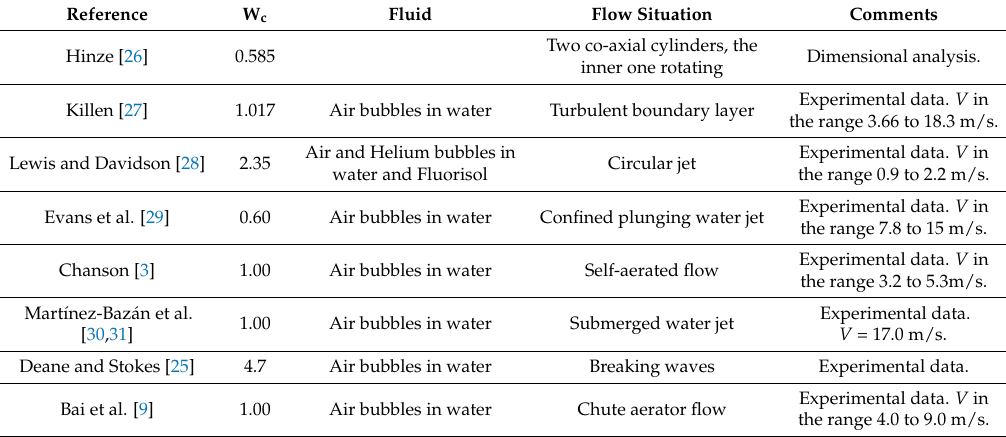
Table 3. Critical Weber numbers for the splitting of air bubbles in water flows.